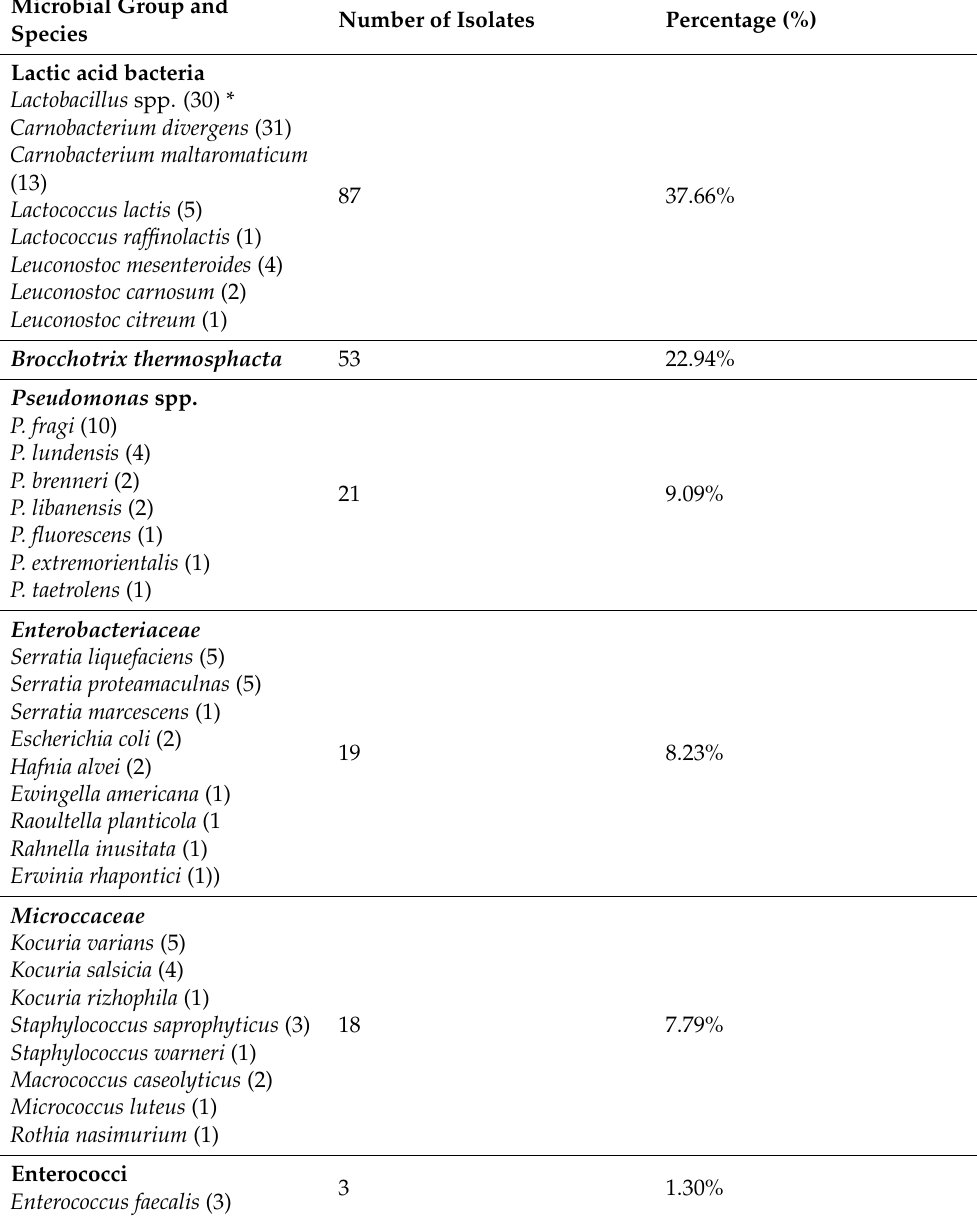
Table 1. Percentage and number of isolates identified in turkey samples from Plate Count